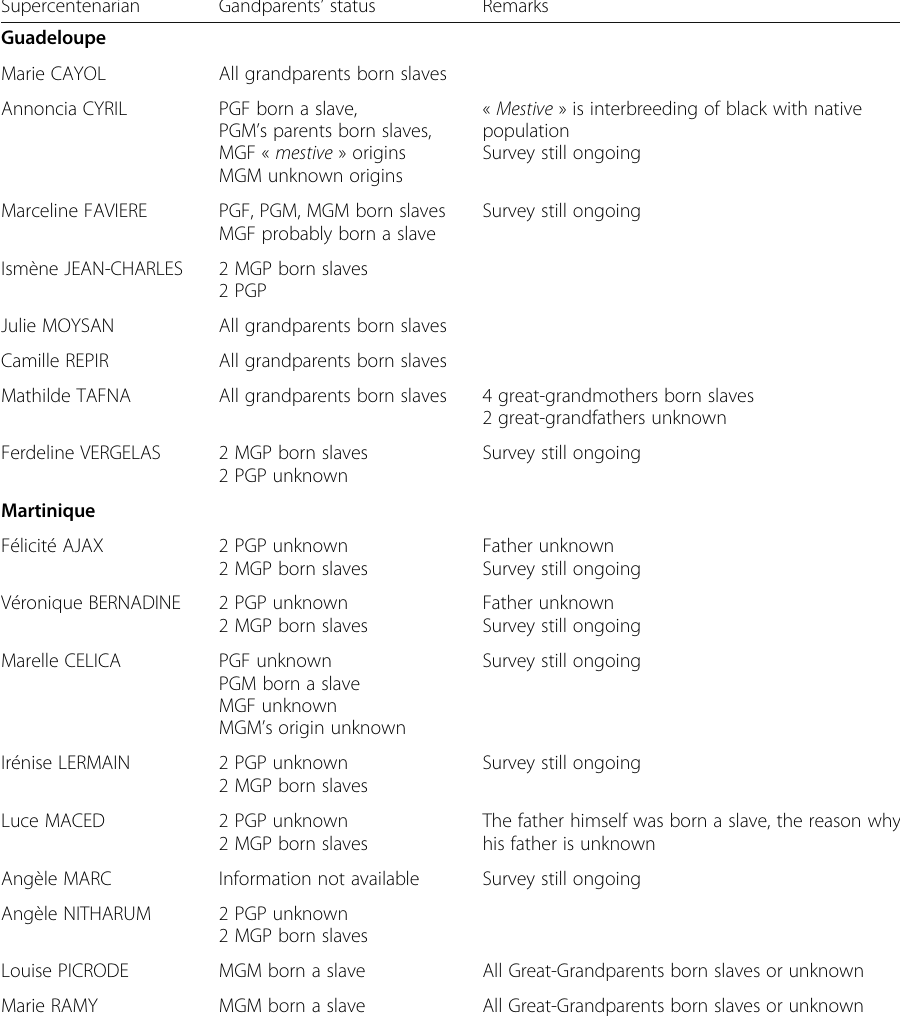
Table 7 Slave origins of the